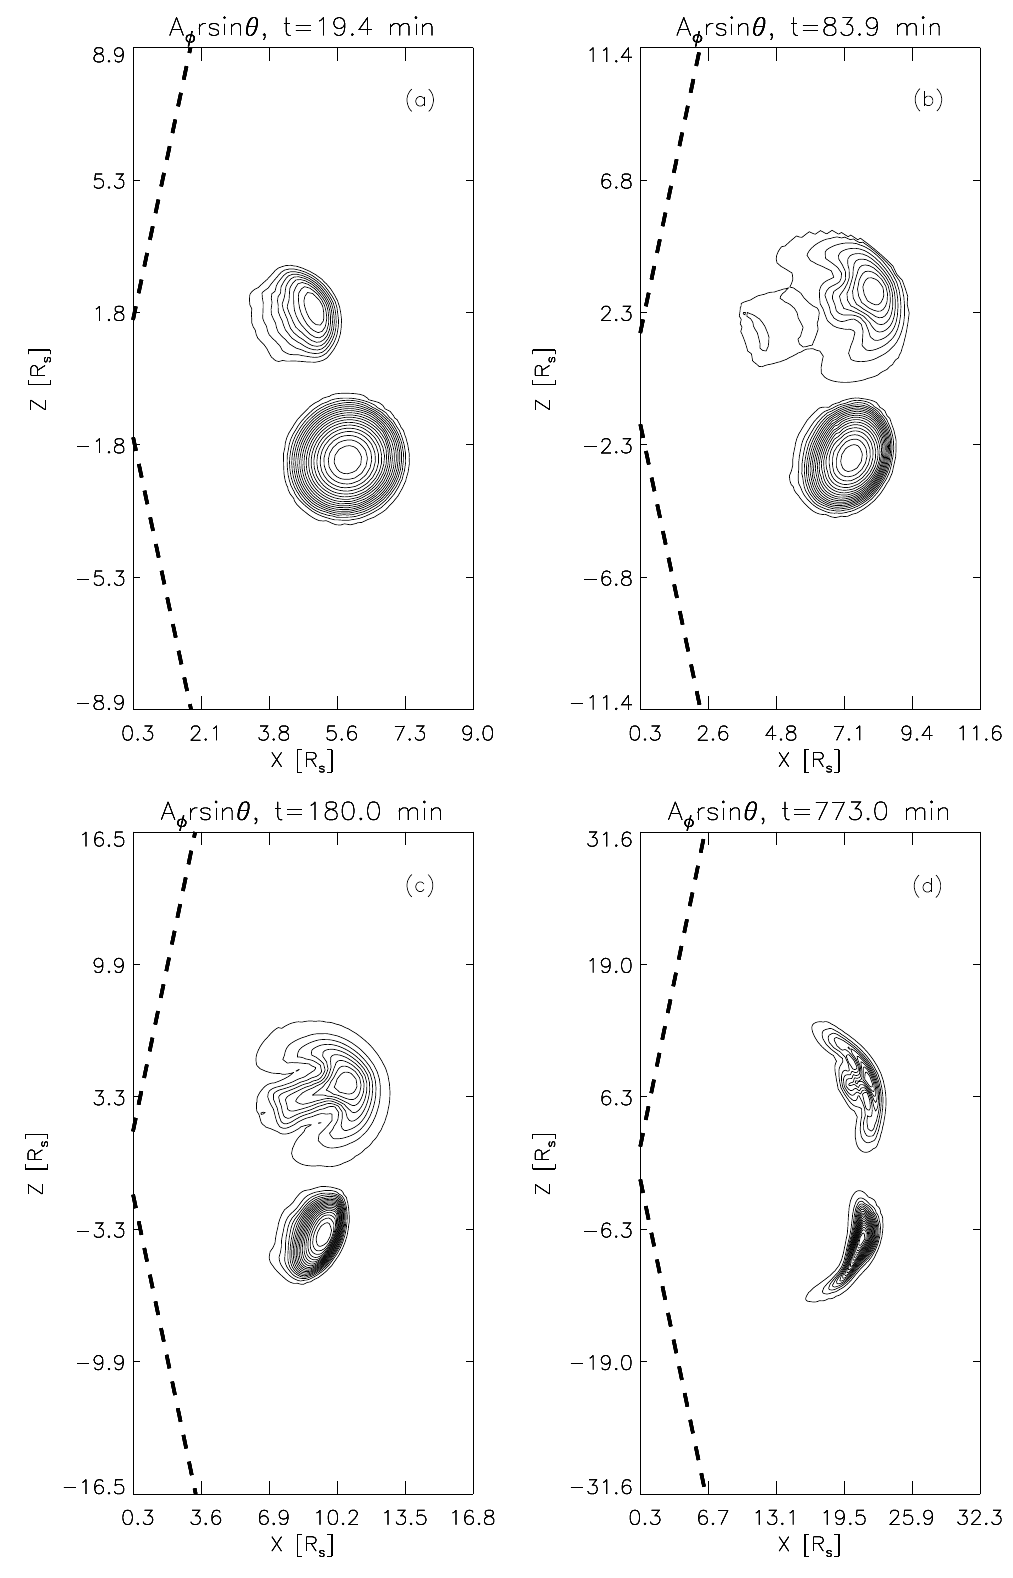
Fig. 1. Contour plots of the vector potential at four times during the evolution of two CMEs whose meridional angle is separated by 40 ◦ . These are projections of the magnetic field on the (r- θ) plane. The same contour levels are used in all